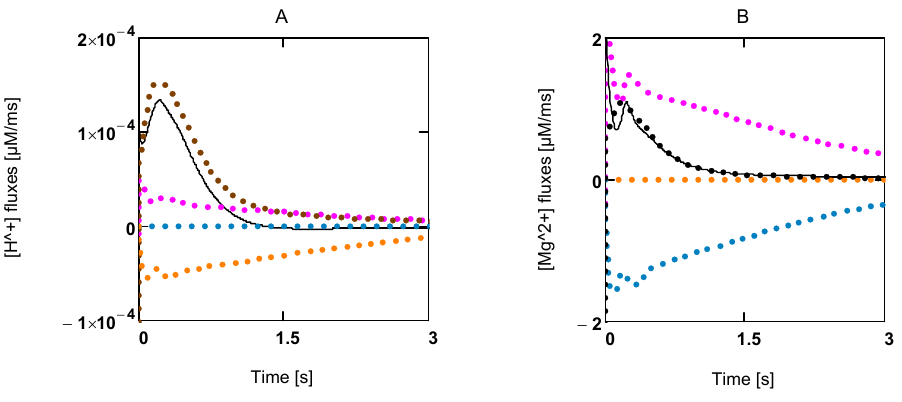
Figure 5. Time courses of [H + ] and [Mg 2+ ] during extreme power output. A: [H + ] fluxes; (brown) mainly LDH reaction and lactate transport; (red) ATP splitting; (blue) J ; (black line) resultant [H + ] flux; B: [Mg 2+ ] fluxes of the same (yellow) J CK